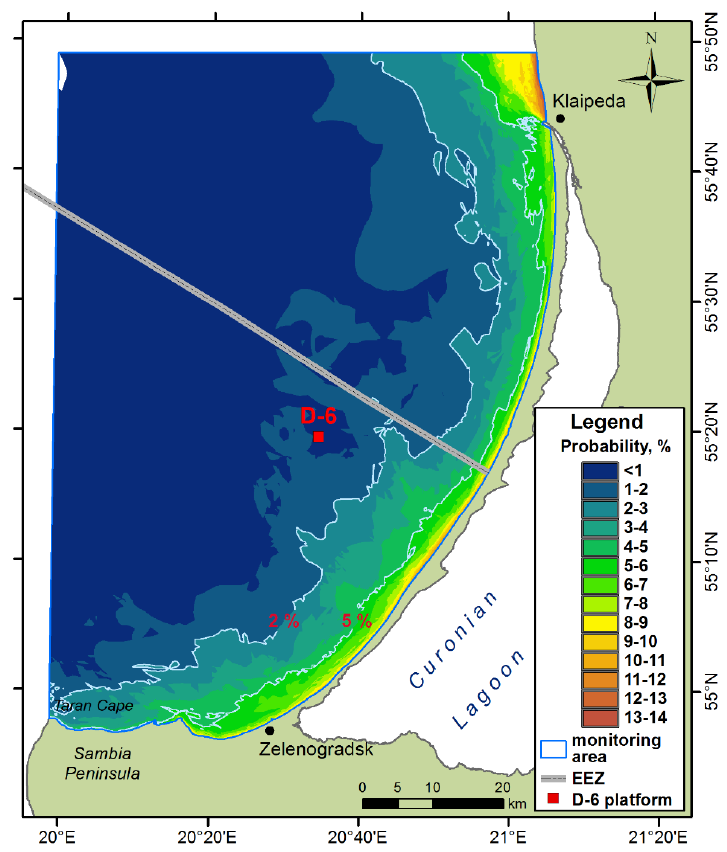
Figure 8. Probability of ice cover observations (%) in the SE Baltic near the Curonian Spit in February according to spaceborne SAR data during an extended period of 2004–2019 [14]. Light blue contours show isolines of 2% and 5% probabilities of ice cover observations.